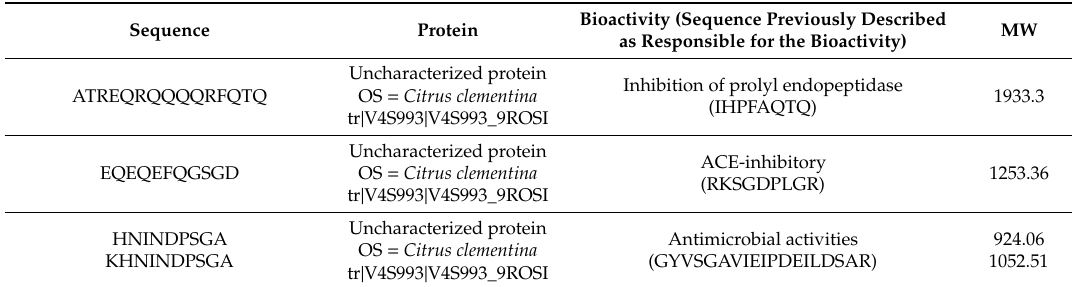
Table 2. Di ff erential peptide sequences present in F(19–20) identified from OSPH (before gastrointestinal (GI) digestion), using NCBInr and UniProt